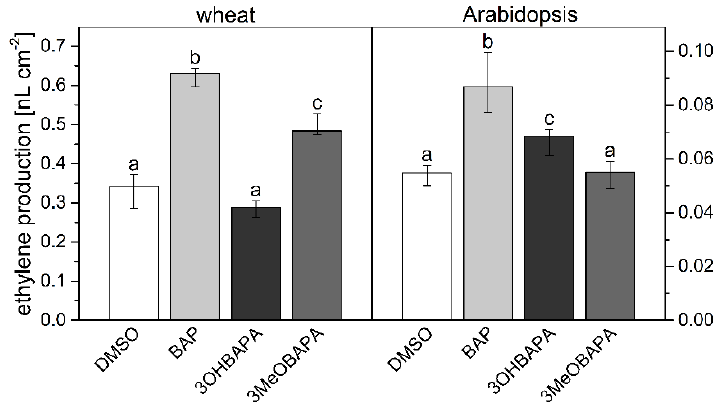
Figure 5. Ethylene production in detached leaves of wheat and Arabidopsis incubated in 0.1% DMSO or 10-µmol·L − 1 solutions of BAP, 3OHBAPA and 3MeOBAPA and kept sealed in 8-mL vials